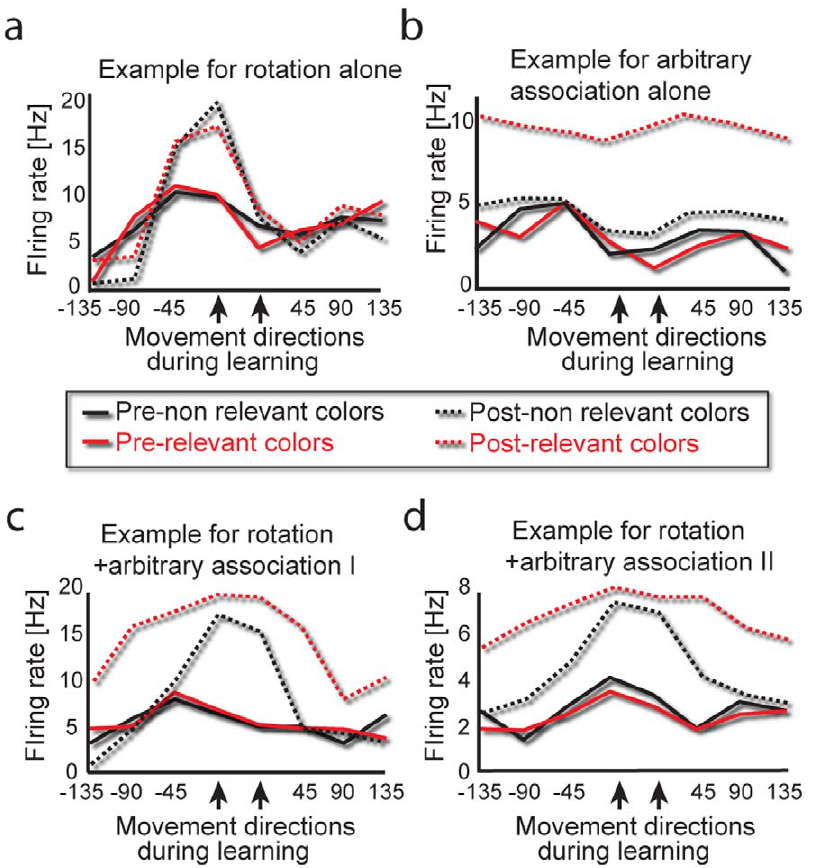
Figure 4. Examples of simultaneous representation in single neurons. Examples of single neuronal responses during the center-out task before and after learning of (a) rotation alone, (b) arbitrary association alone or (c–d) rotation followed by arbitrary association. Red indicates center- out responses to target colors used during the learning blocks, black indicates responses to target colors not used. Solid lines represent activity before learning; dashed lines represent activity after learning. Directions are aligned according to distance from the direction used during the learning blocks.